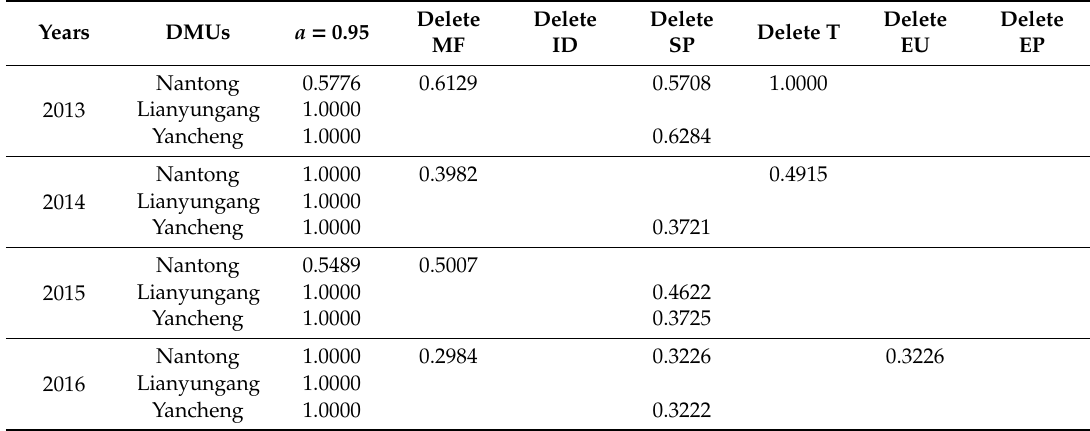
Table A11. The changes of stochastic e ffi ciency value by deleting grouping input variables in Coastal Area ( α =